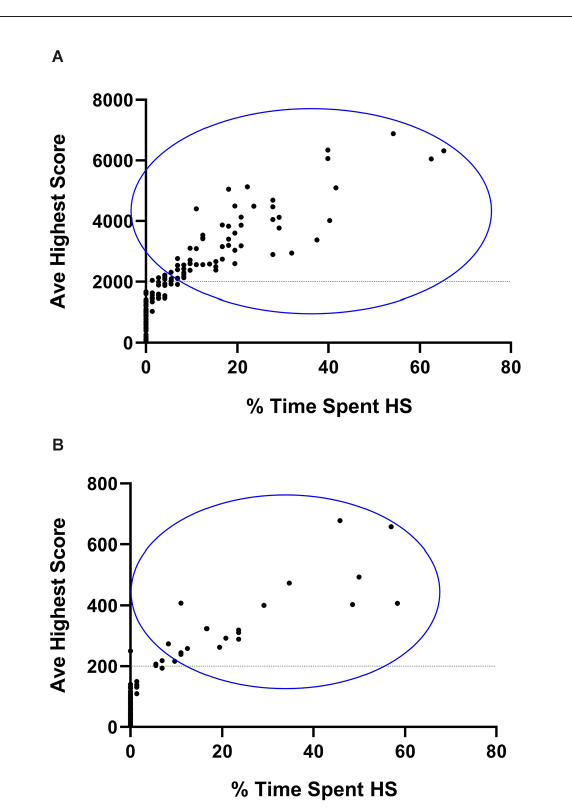
FIGURE2 Graphical representation of animals selected for non- (NS) and high stereotypical (HS) behavior. Average highest vertical stereotypy (A) and horizontal running (B) scores generated by 180 deer mice plotted against the percentage time spent engaging in HS behavior. Y-axis data are representative of the nine highest stereotypical bouts generated over the three baseline assessment sessions. X-axis data are representative of the total number of HS bouts expressed over all 72 baseline bouts. Animals enclosed in the blue circle were included in the HS, some of which may have expressed HS behavior across both